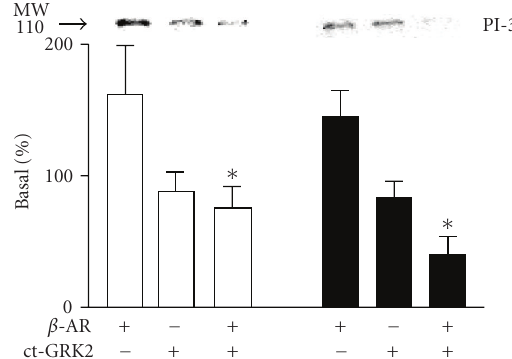
Figure 4: GRK2 carboxy-terminal domain reduced PI-3K recruit- ment to membrane fractions in response to β -AR stimulation . HEK 293 cells were cotransfected with ct-GRK-2 and β -AR subtypes. Forty-eight hours after the transfection, cells were stimulated with 1 μ M isoproterenol for 5 minutes. PI3-kinase recruitment to particulate fractions decreased with cells expressing either β 1 -AR ( (cid:2) ) or β 2 -AR ( (cid:3) ) in presence of cotransfected ct-GRK2. Top panel is a representative immunoblot of the experiments ( n = 4–6). Data from these experiments is quantitated in the bottom panel as described in Section 2. ∗ P < . 05 versus 0